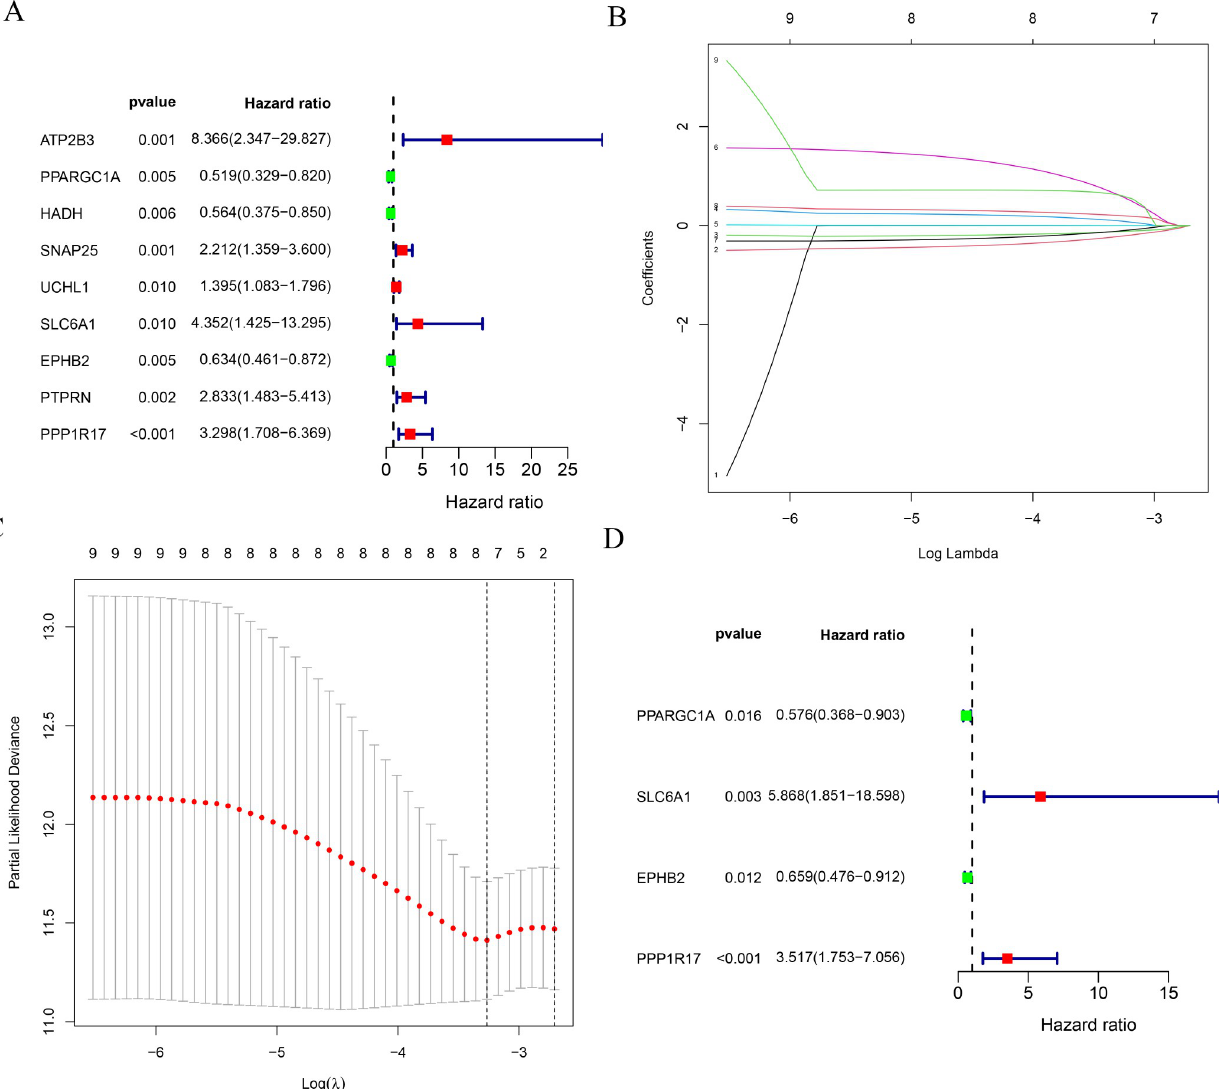
Fig 4. Selection of prognosis-related MRGs in the training group. (A) Results of univariate Cox regression analysis. (B and C) Results of least absolute shrinkage and selection operator (LASSO) regression analysis. (D) Mitophagy-related genes (MRGs) most relevant to prognosis identified by multivariate Cox regression analysis.